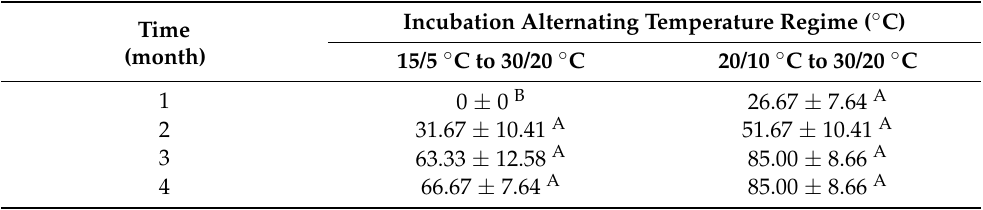
Table 3. Percentage of cumulative shoot emergence (mean ± SD) of Quercus chungii transferred to 30/20 ◦ C after 8 months under 15/5 ◦ C or 20/10 ◦ C